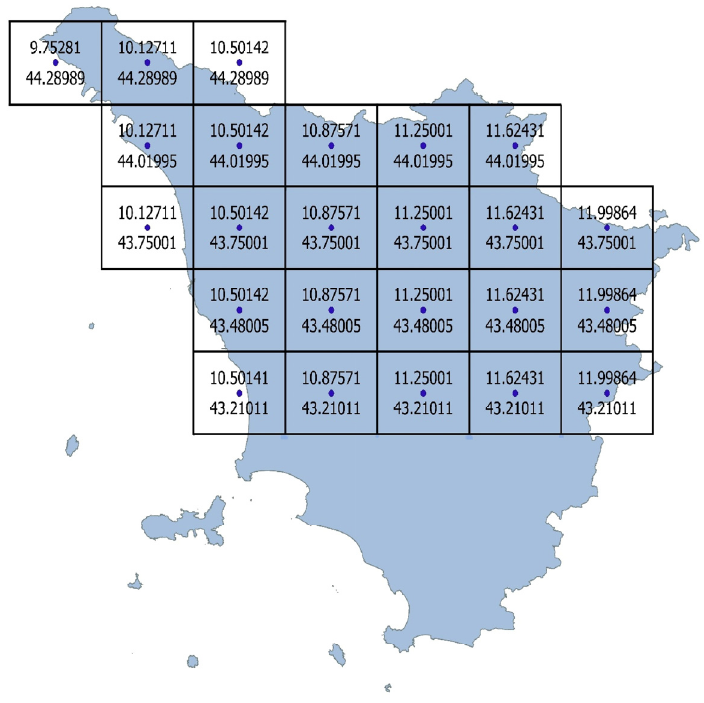
Figure 2. Areas where the ACR was estimated. Latitude and longitude of the centers of the areas expressed in decimal degrees are indicated below and above